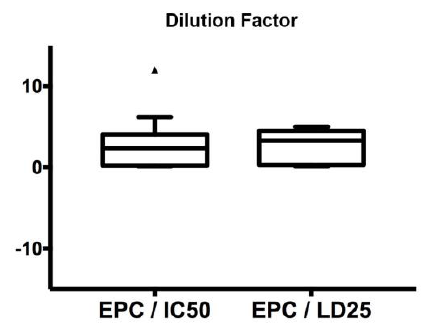
Figure 2. Estimation of the maximum tolerated dose (MTD). Box plot displaying equivalent plasma concentration EPC/IC50 and EPC/LD25 ratios for all chemotherapy protocols.